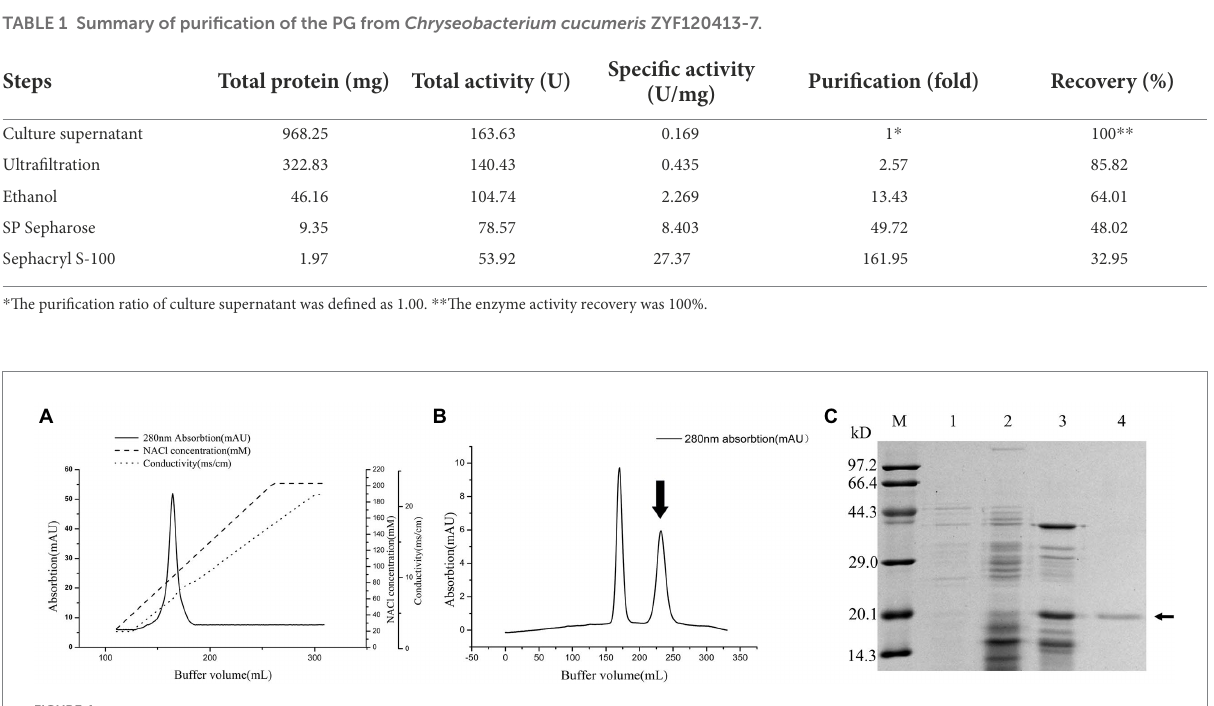
FIGURE 4 Chromatography of the crude Protein-glutaminase (PG) from Chryseobacterium cucumeris ZYF120413-7 subjected to cation exchange chromatography on SP Sepharose Fast Flow 16/10 column (A) , and gel filtration chromatography on Sephacryl S-100 HR 26/60 column (B) , the arrow indicated the active fraction containing PG activity, and sodium dodecyl sulfate polyacrylamide gel electrophoresis (SDS-PAGE) analysis of the PG purification steps (C) , M, molecular mass marker; 1, broth supernatant; 2, crude PG after ethanol precipitation; 3, crude PG after SP Sepharose FastFlow; 4, purified PG after Sephacryl S-100 HR, the arrow marks the position of